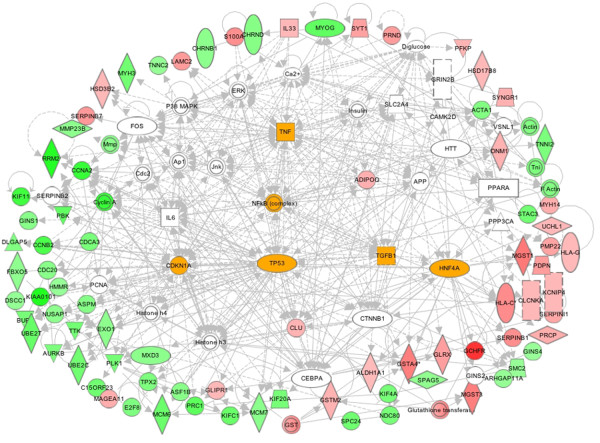
Major intracellular networks of cardiac genes that were differentially modulated by TSA at 24h. The dominant nodes, centered by TGFβ, TP53, HNF-4A.TNF.α, CDKN1A and NFkB, are highlighted; signaling nodes of ERK-JNK-p38MAPK are also present as prominent nodes.